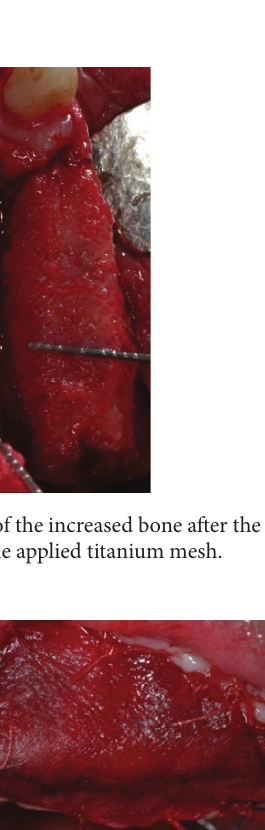
Figure 12: Two-year postoperative X-ray control evidences the integration of the dental implants for support of a fixed prosthetic rehabilitation.